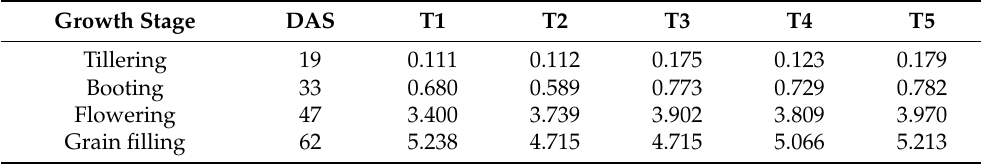
Table 5. Mean values for dry biomass (t ha − 1 ) according to each treatment.